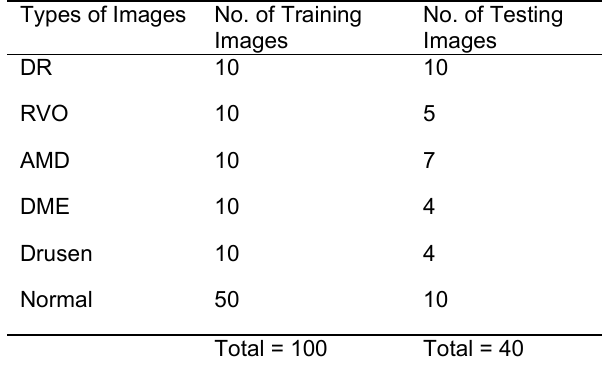
Table 5. Details of Training and Testing